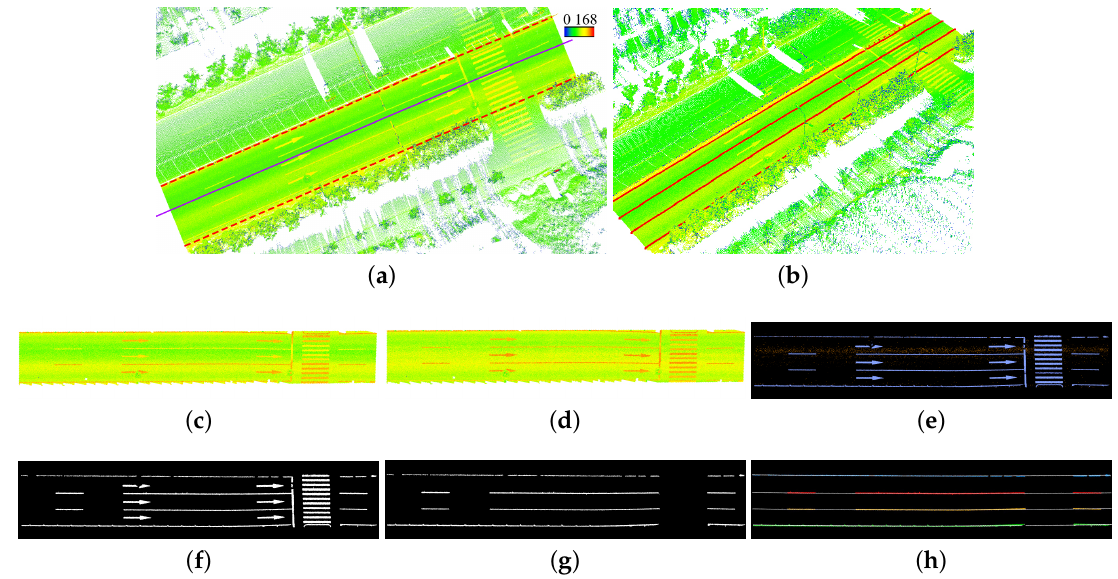
Figure 19. A three-lane road section. ( a ) The raw data. The color from blue to red indicates the intensity from low to high. The purple line is the trajectory and the red dotted lines are the road edges. ( b ) The 3D lane lines are presented in the colored point cloud. ( c ) The road points that are segmented by the edges. ( d ) The road points after intensity correction. ( e ) The 2D intensity image. The blue parts are the road markings while the orange part is the interference. ( f ) The binary image that contains all the road markings. ( g ) The binary image that contains only the lane markings. ( h ) The lane-marking pixels are clustered into groups and each group is marked by a unique color. The white lines are the fitted lane